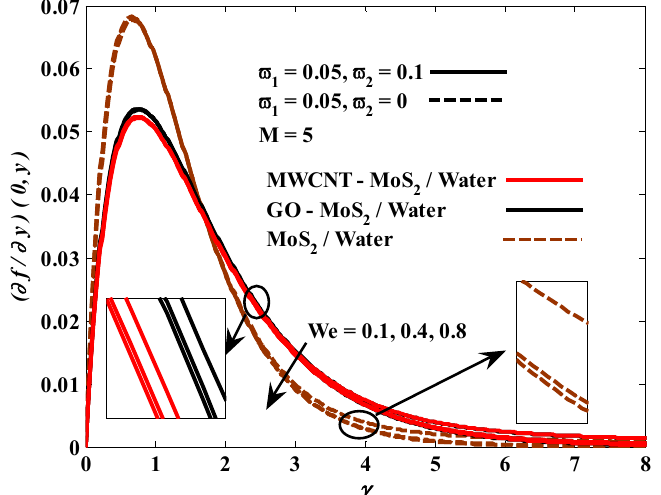
Figure 13. The behavior of hybrid nanofluid’s velocity under the effect of We.